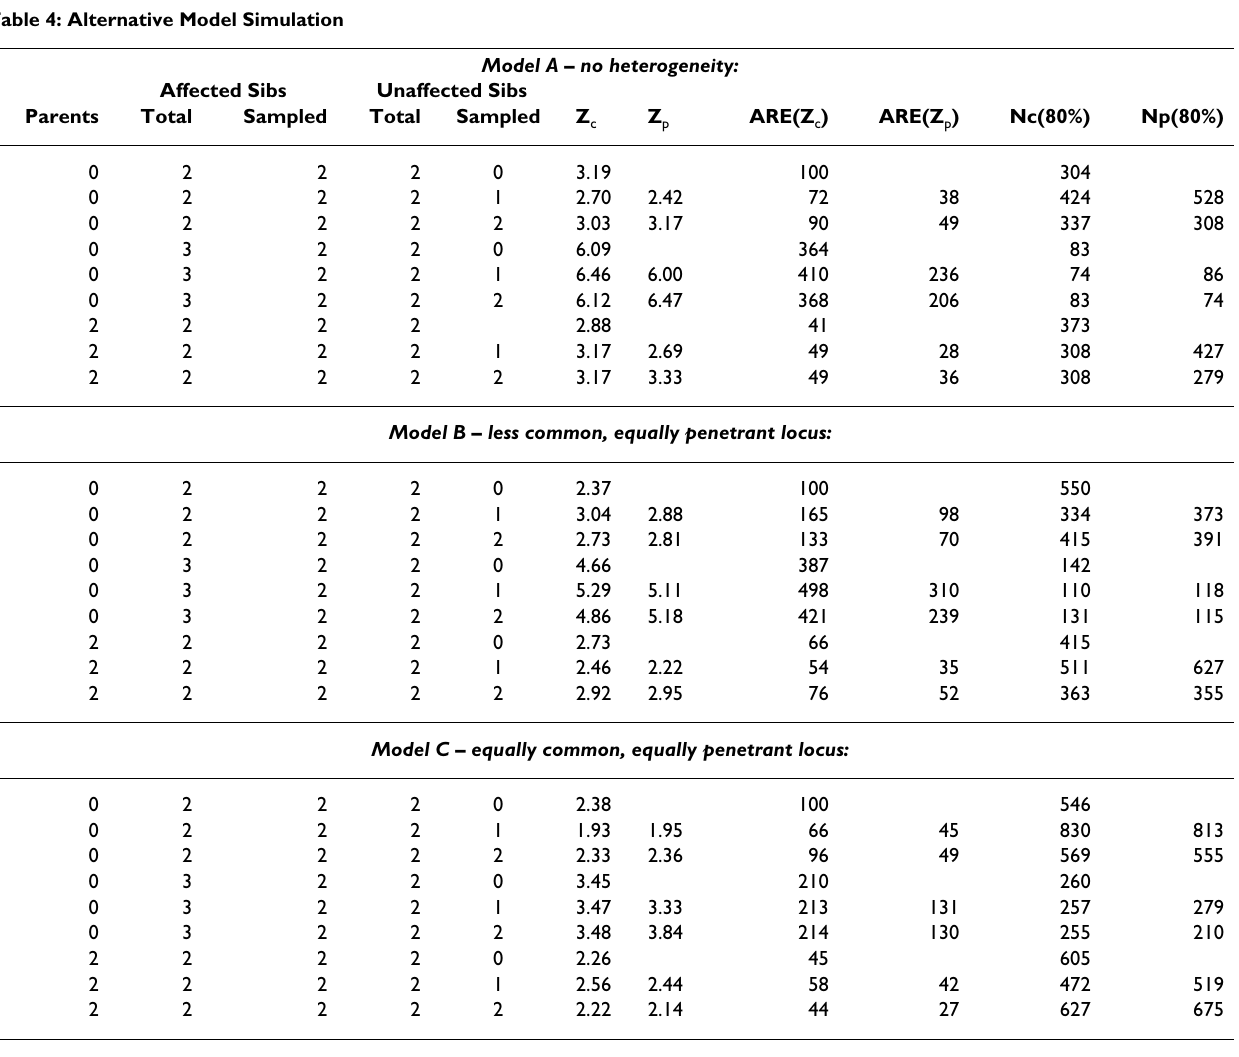
Model A – no heterogeneity: